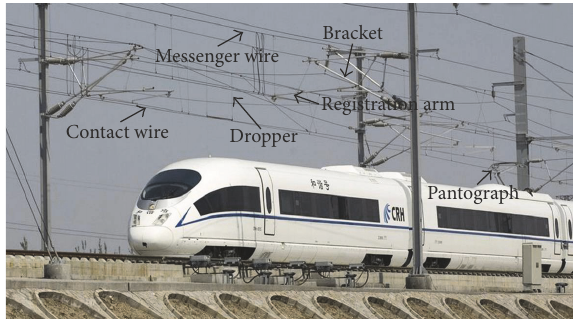
Figure 1: A simple stitched catenary